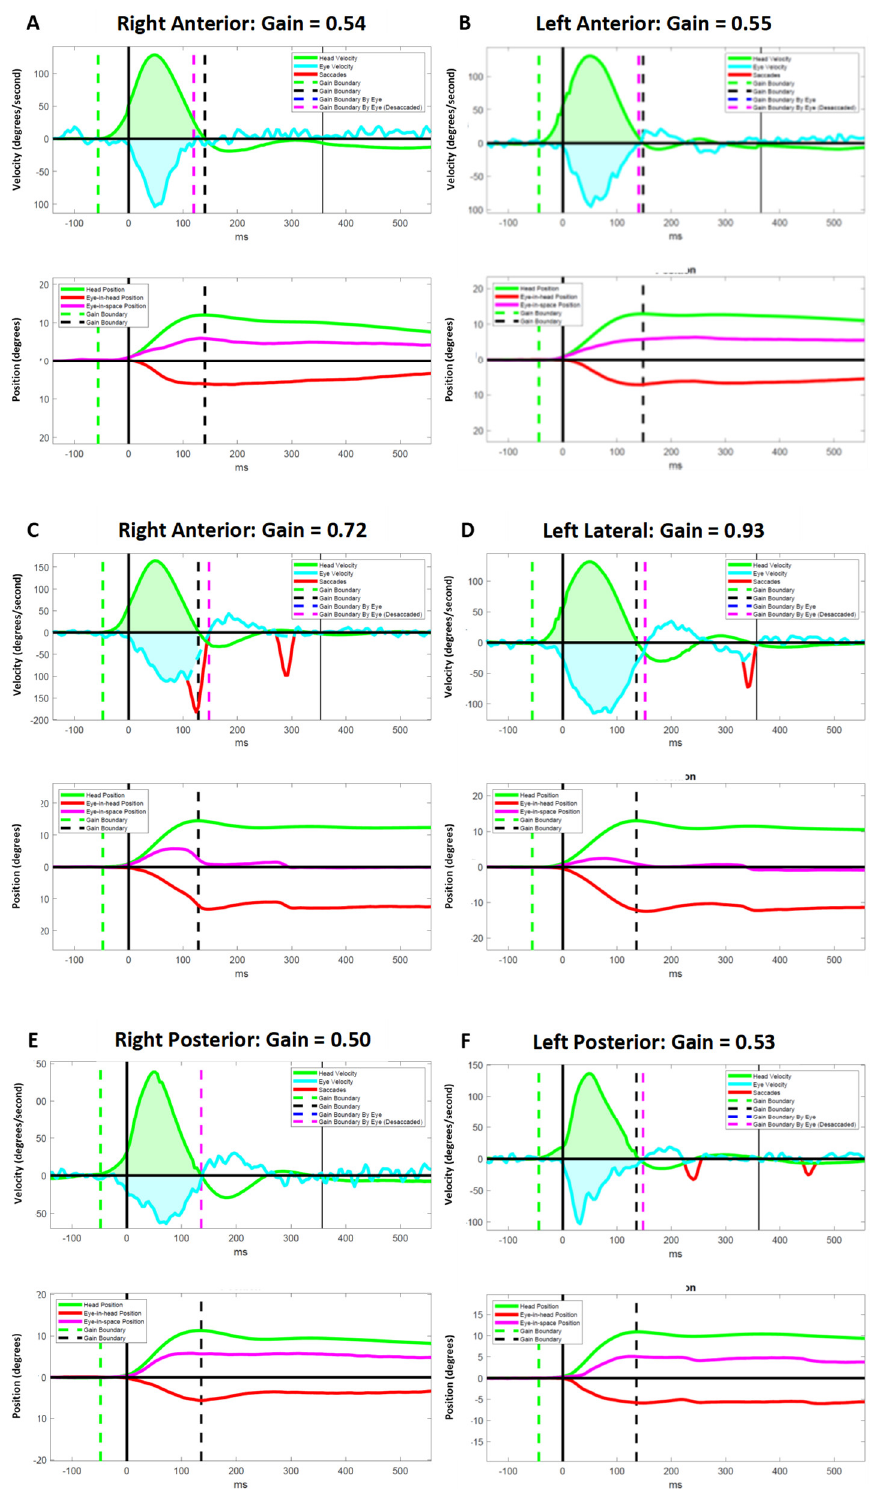
Figure 1. Representative video head impulse test results for a participant with moderate MS who failed to generate effective compensatory saccades in response to vertical head impulses despite having abnormal vestibulo–ocular reflex (VOR) gains for the vertical canals. This subject did generate compensatory saccades with lateral impulses despite having better VOR gains for the right and left lateral canals. Data for the anterior ( A , B ), lateral ( C , D ), and posterior ( E , F ) canals are shown in the velocity (upper panels) and position (lower panels) domains. ms = milliseconds.